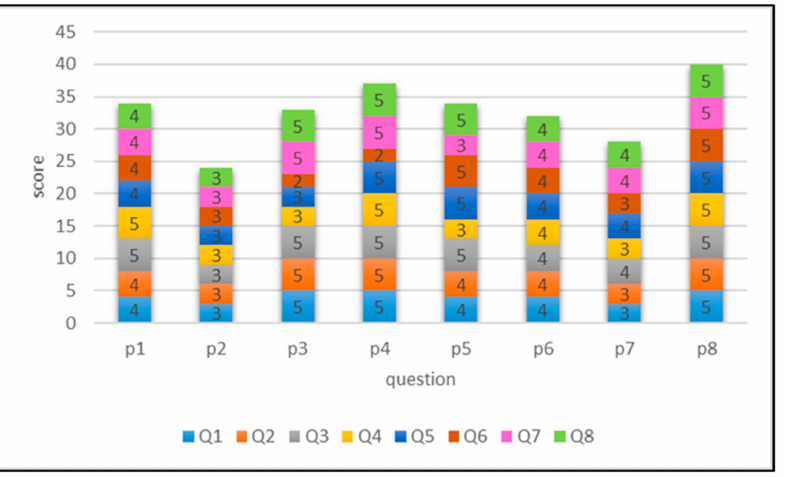
Figure 14. Stack graph of satisfaction score survey results (P1—8 are participants and Q1—8 are questions).